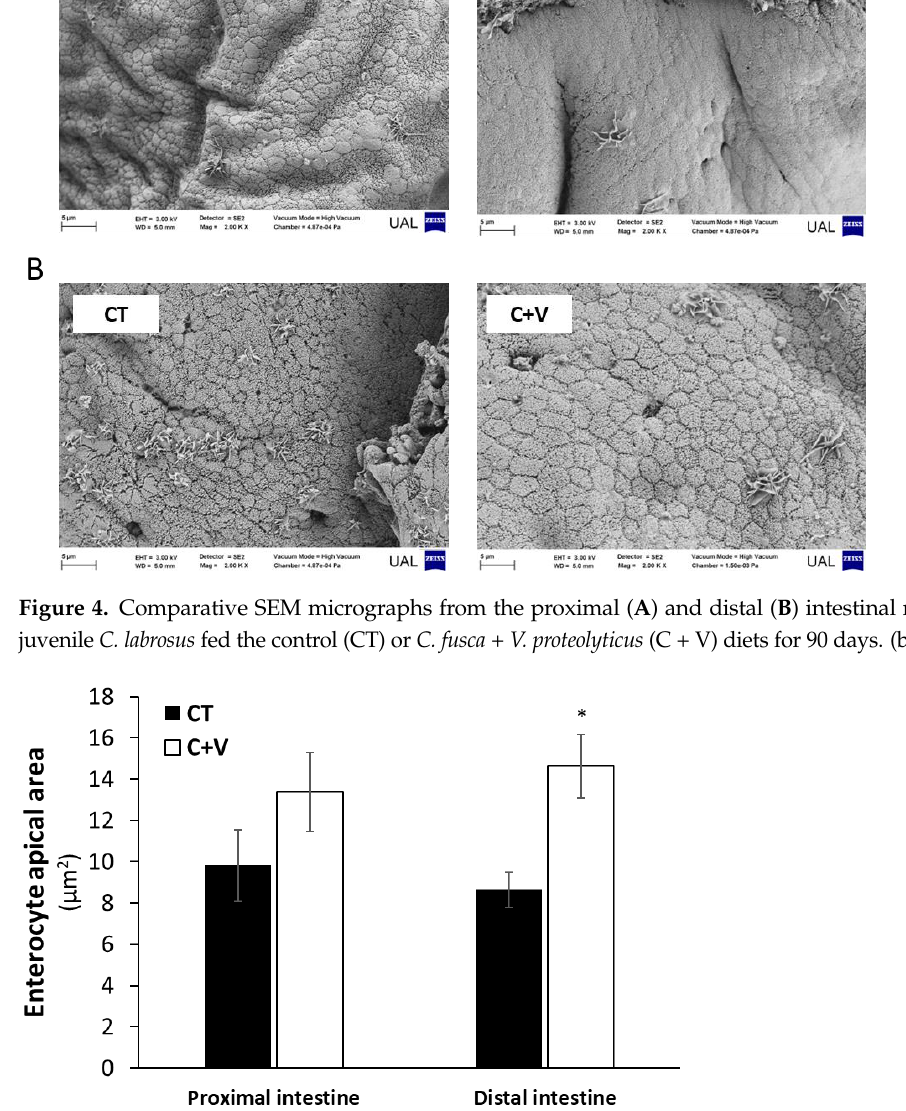
Figure 5. Enterocyte apical area (µm 2 ) of the proximal and distal intestinal regions of juvenile C. labrosus fed the control (CT) or C. fusca + V. proteolyticus (C + V) diets for 90 days. Values are ex- pressed as mean ± SEM ( n = 50 measurements per treatment). Asterisks denote significant differ- ences ( p < 0.05) between experimental diets in the same intestinal region.